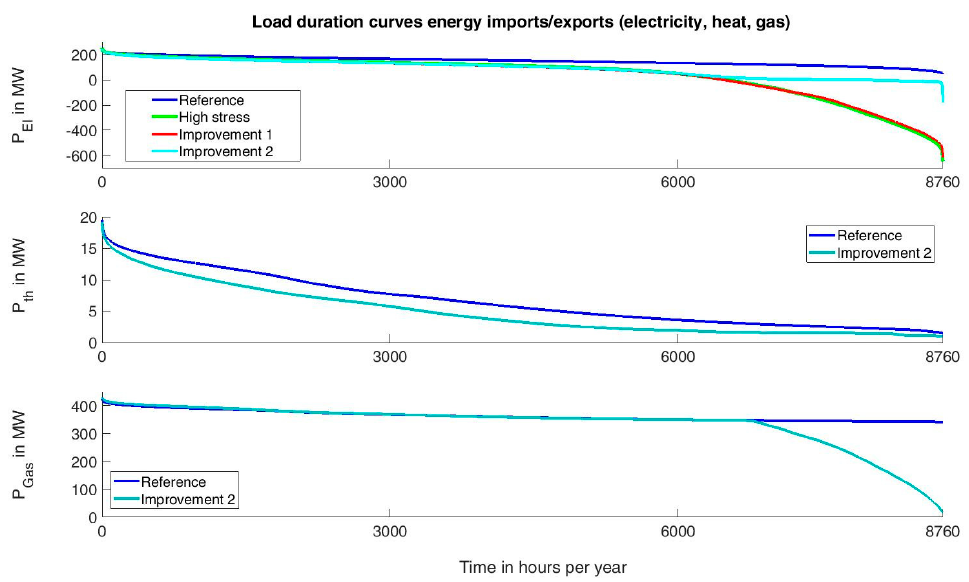
Figure 10. Load duration curves of energy imports/exports for all energy carriers and one year.